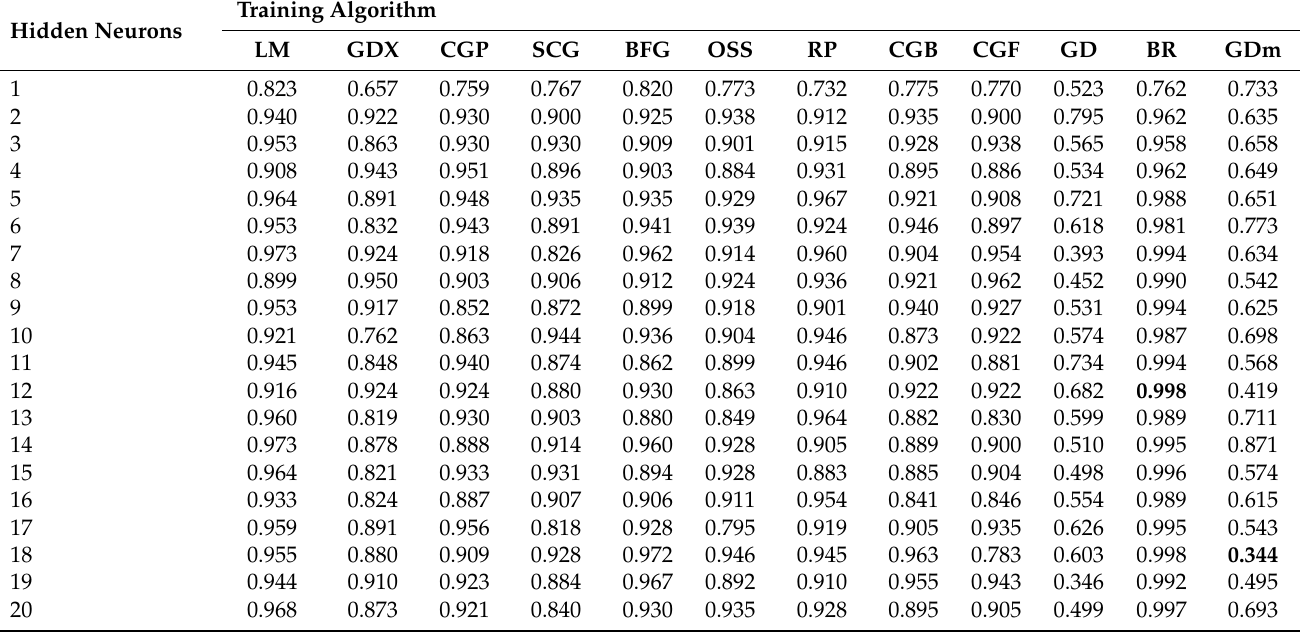
Table A7. R value for COD removal (%) for different training algorithms at different number of hidden neurons.